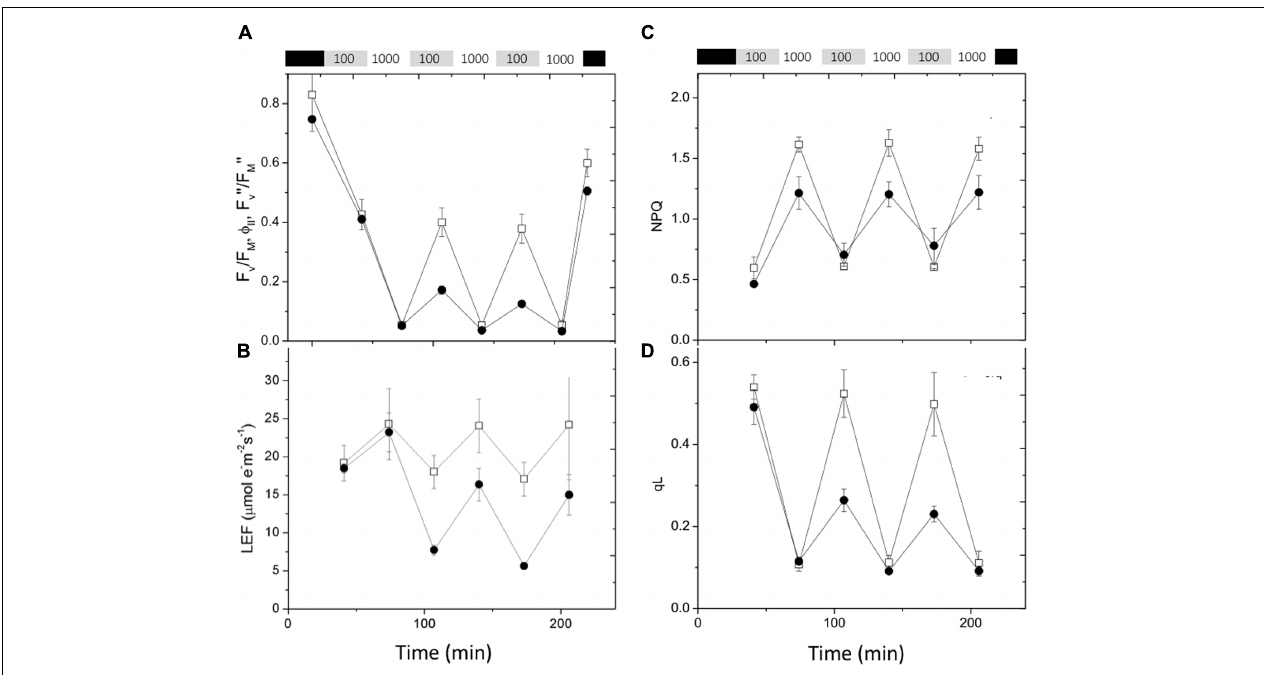
FIGURE 6 | Responses of chlorophyll fluorescence parameters to fluctuating illumination in Col-0 and cfq . Plants were dark adapted for at 20 min and exposed to fluctuating light (30 min each of 100 and 1000 µ mol photons · m − 2 · s − 1 ) over a 4-h period. (A) Kinetics of quantum PSII efficiency, taken in dark adapted leaves (F V /F M ), during steady-state illumination ( φ II ) and after 20 min of dark adaptation following light exposure (F V (cid:48)(cid:48) /F M (cid:48)(cid:48) ); (B) LEF; (C) non-photochemical quenching (NPQ); and (D) Q A redox state (q L ). Symbols indicate Col-0 (open squares) and cfq (closed